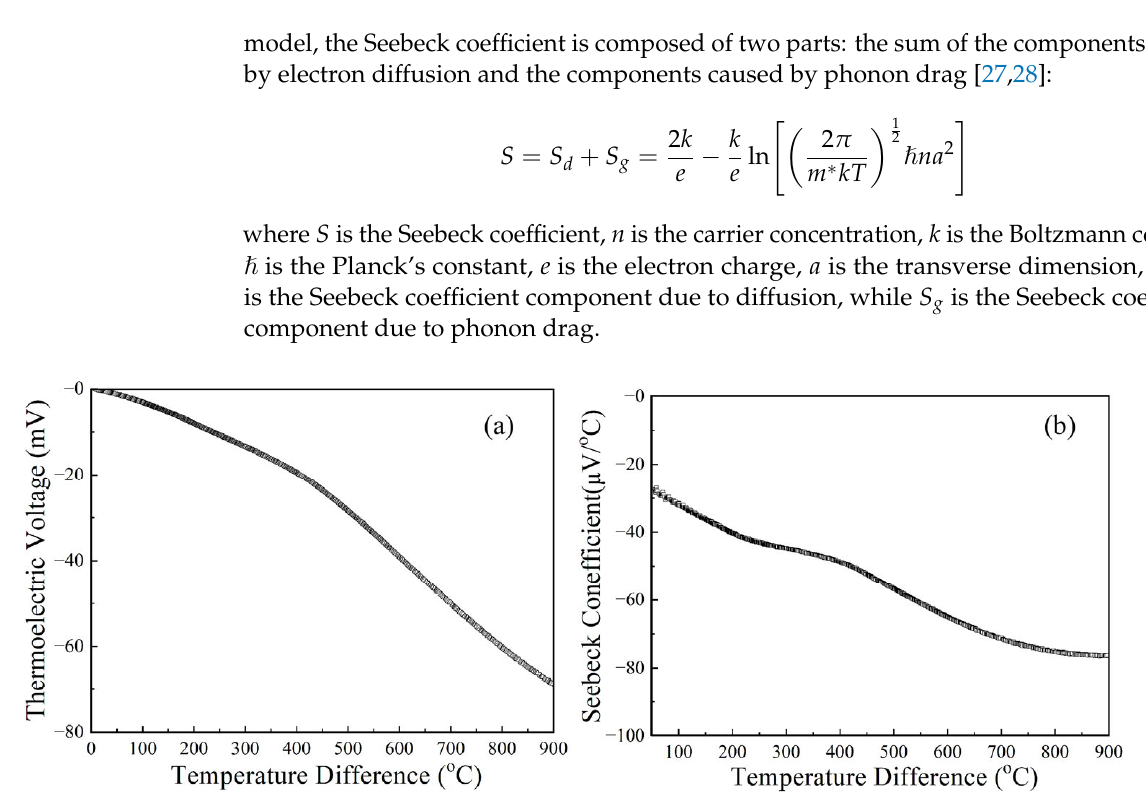
Figure 6. Thermoelectric response curve of ITO/Pt thermocouple. ( a ) Thermal voltage output; ( b ) Seebeck